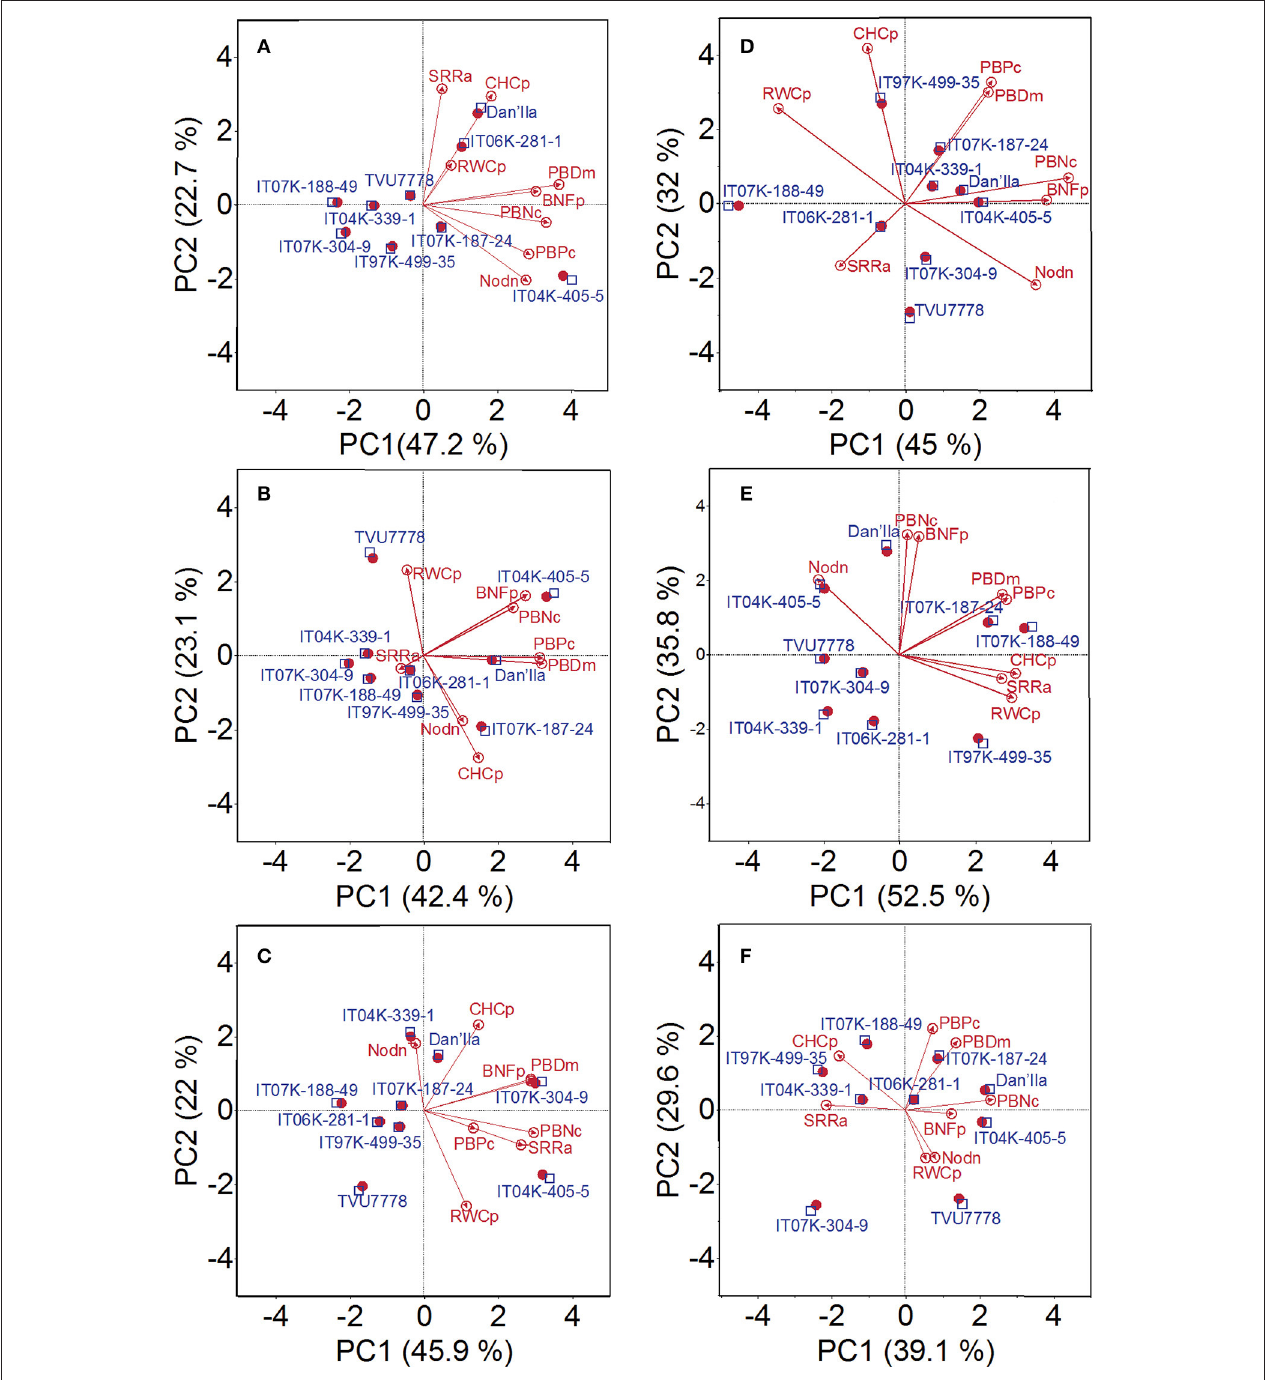
FIGURE 4 | Principal component (PC) analysis displaying the cowpea varieties under (A) water deficit and low available soil-Pi level, (B) water deficit and moderate available soil-Pi level, (C) water deficit and high available soil-Pi, (D) well-watered and low available soil-Pi, (E) well-watered and moderate available soil-Pi, and (F) well-watered and high available soil-Pi conditions. PCs 1 and 2, and their respective contributions are indicated. Nodn, nodule number; SRRa, shoot/root ratio; PBDm, plant (shoot + root) biomass dry matter; PBPc, plant (shoot + root) P content; PBNc, plant (shoot + root) N content; BNFp, biological nitrogen fixation potential; RWCp, relative water content of plant shoots; CHCp, chlorophyll content.